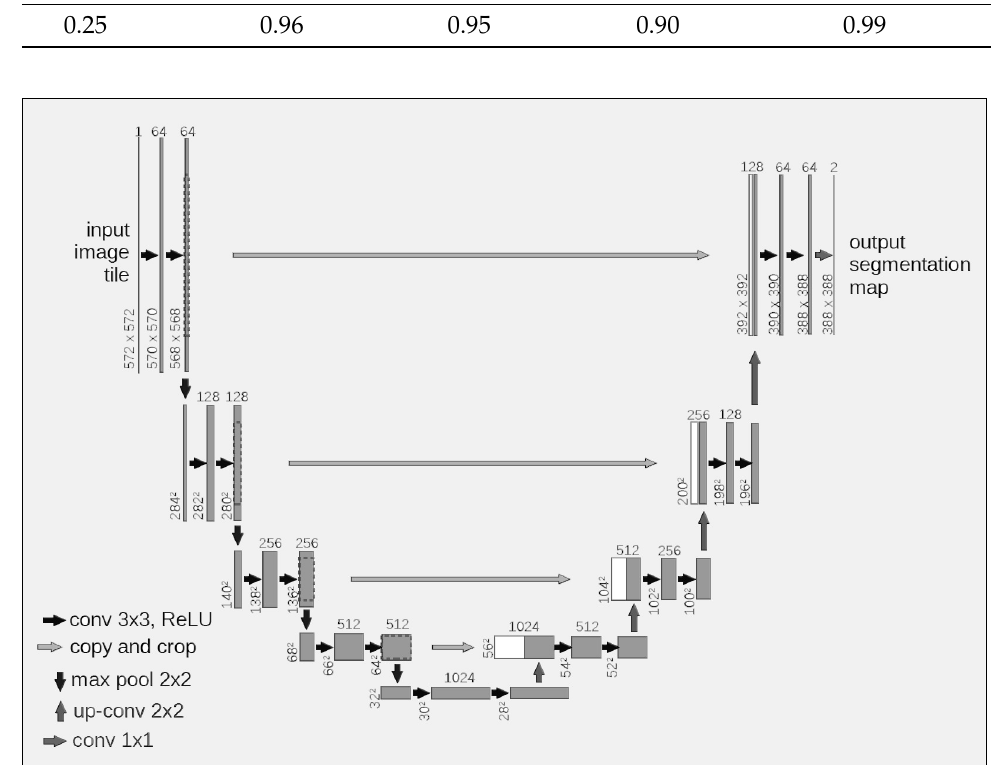
Figure 4. U-Net architecture for